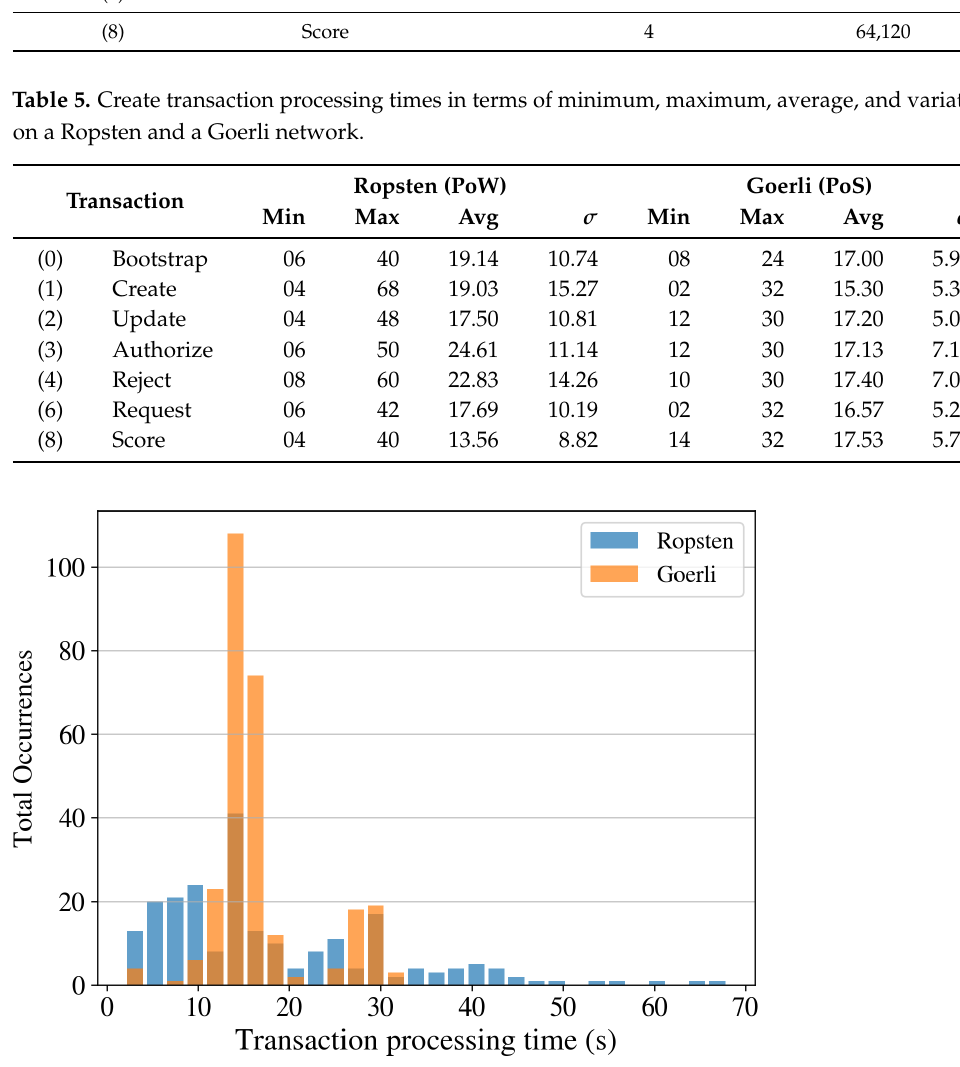
Figure 14. Transaction processing time for Ropsten and Goerli